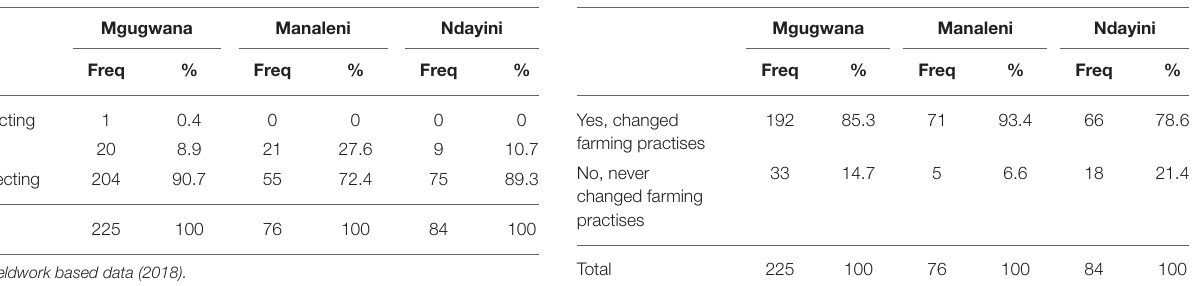
TABLE 5 | Extent at which climate change affect food production. TABLE 6 | Changed farming practises in order to adjust to climate